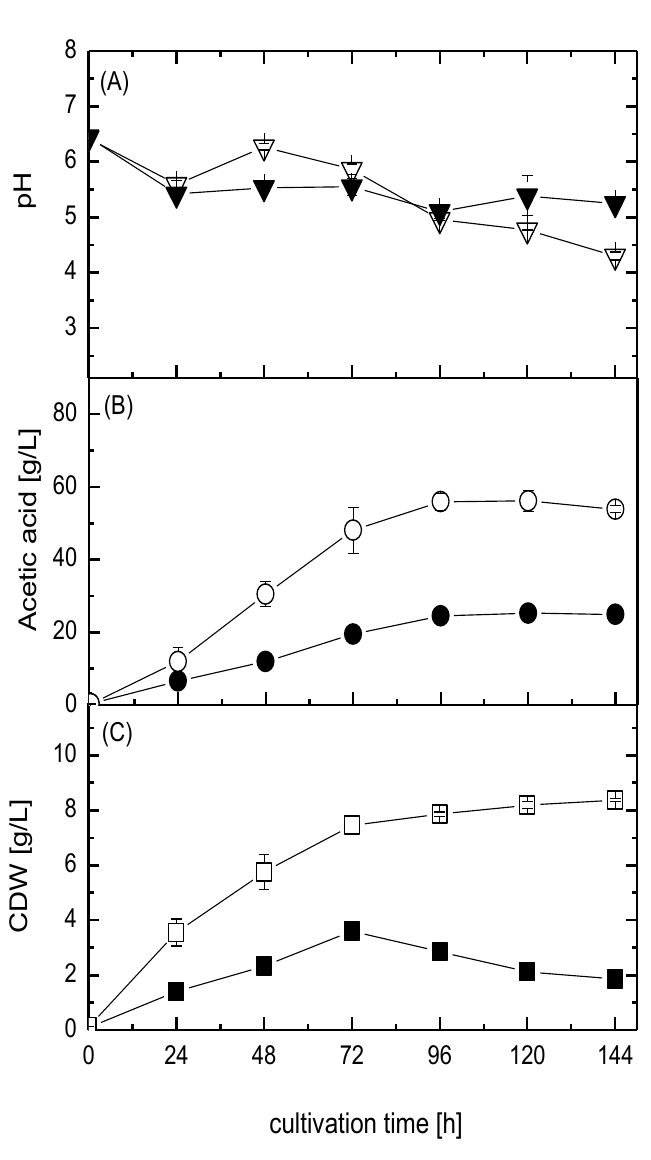
Figure. 5. Changes in Cell growth, acetic acid production and pH during cultivations in shake flask culture. Closed and opened symbols for medium before and after optimization,